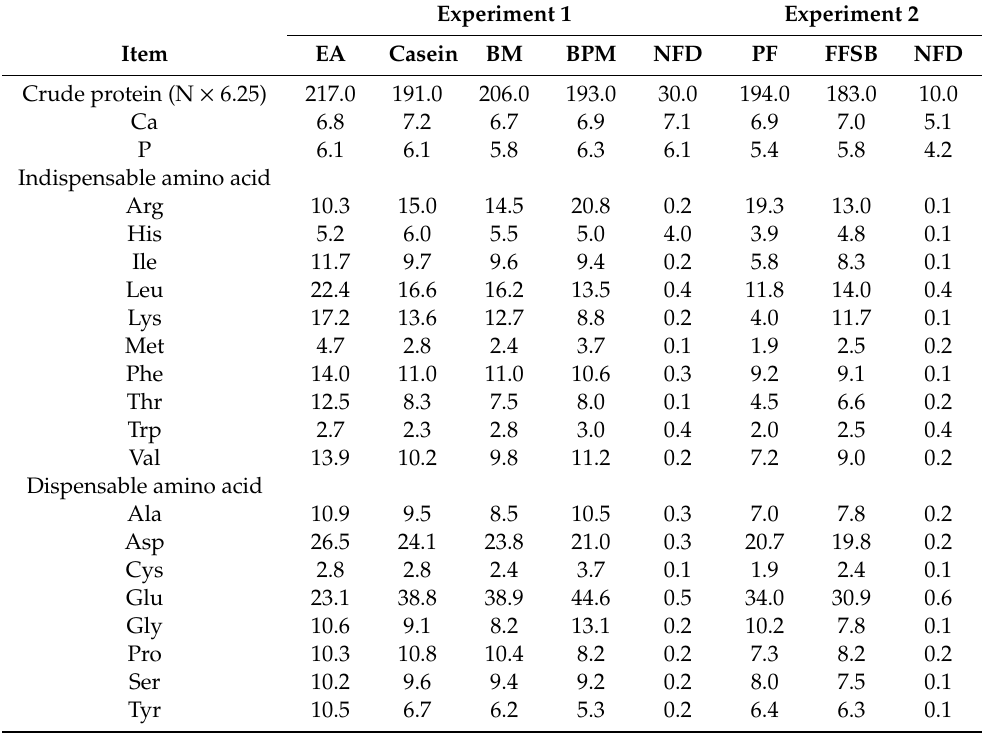
Table 3. Analyzed nutrient composition of experimental diets, g / kg as-fed basis 1 . Experiment 1 Experiment 2